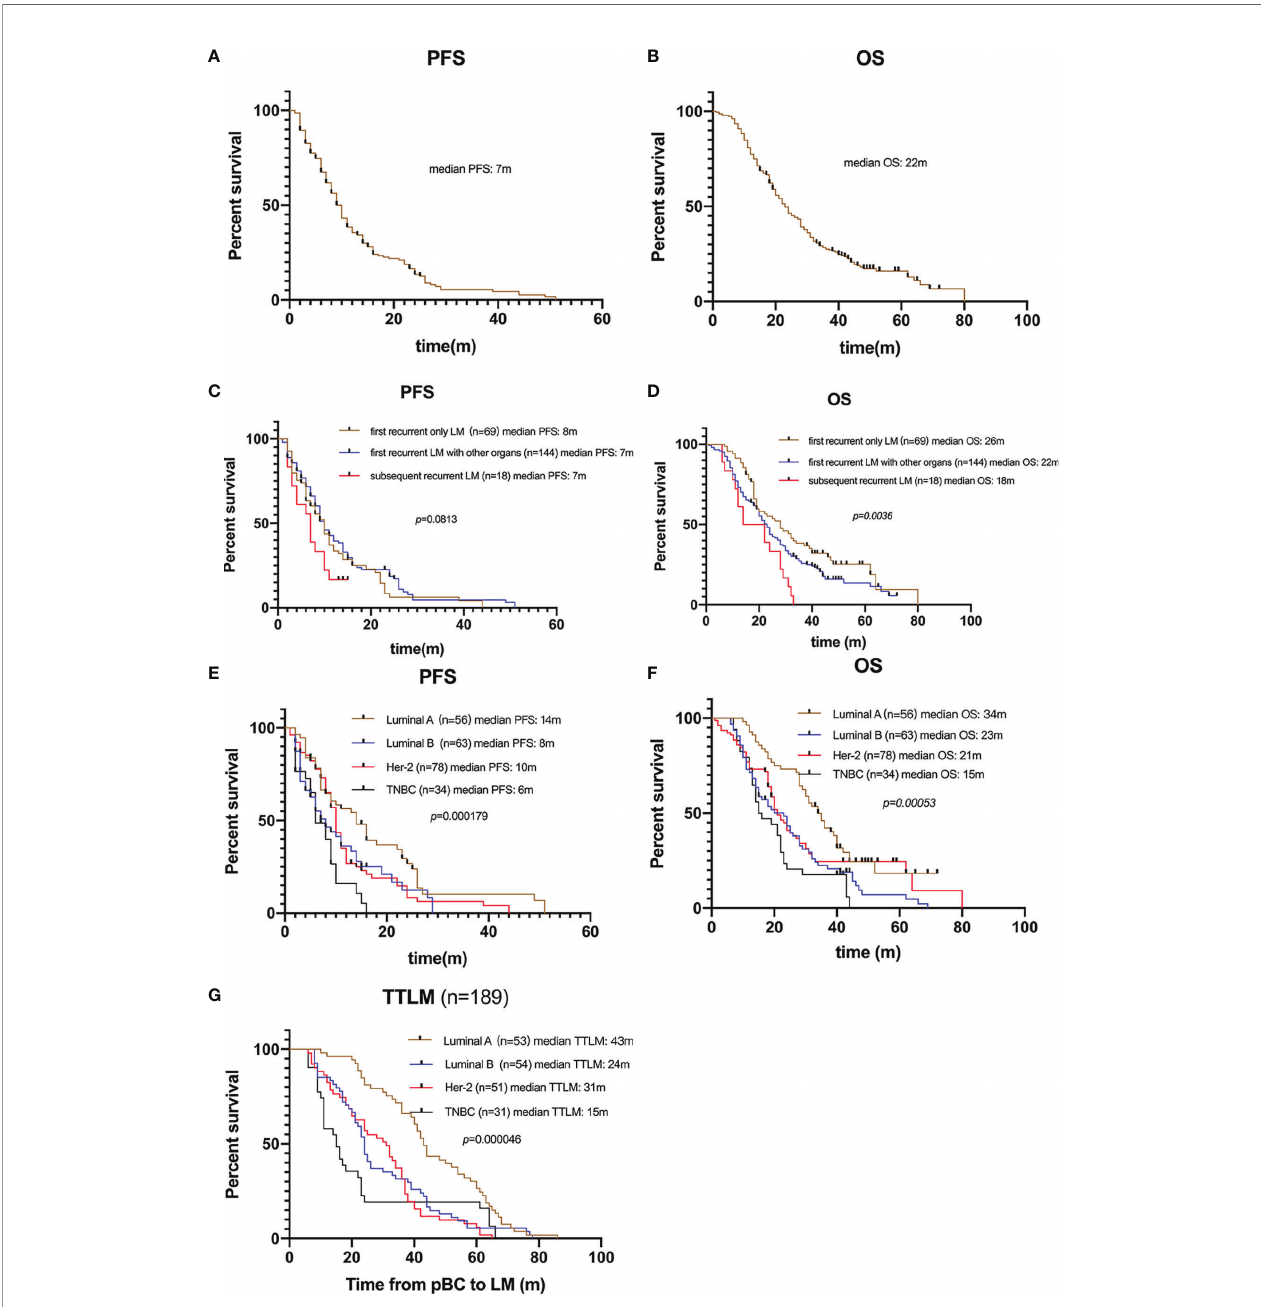
FIGURE 2 | Survival of patients with LM. (A) Kaplan – Meier PFS curve of 231 patients with LM. (B) Kaplan – Meier OS curve of 231 patients with LM. (C) Kaplan- Meier plots illustrating PFS of patients with “ only LM initially ” , “ LM with other organs initially ” , and “ subsequently recurrent LM ” , respectively. No signi fi cant difference in PFS among groups (8 vs. 7 vs. 7 months, p = 0.0813). (D) Kaplan-Meier plots illustrating OS of patients with “ only LM initially ” , “ LM with other organs initially ” , and “ subsequently recurrent LM ” , respectively. Patients with only LM initial presence were associated with longer OS (26 vs. 22 vs. 18 months, p = 0.0036). (E) Kaplan- Meier plots illustrating PFS of patients with different molecular subtypes. Patients with TNBC were associated with shorter PFS (14 vs. 8 vs. 10 vs. 6 months, p = 0.000179). (F) Kaplan-Meier plots illustrating OS of patients with different molecular subtypes. Patients with TNBC were associated with shorter OS (34 vs. 23 vs. 21 vs. 15 months, p = 0.00053). (G) Kaplan-Meier plots illustrating time from pBC to LM (TTLM) of patients with different molecular subtypes. Patients with TNBC were associated with shorter TTLM (43 vs. 24 vs. 31 vs. 15 months, p =